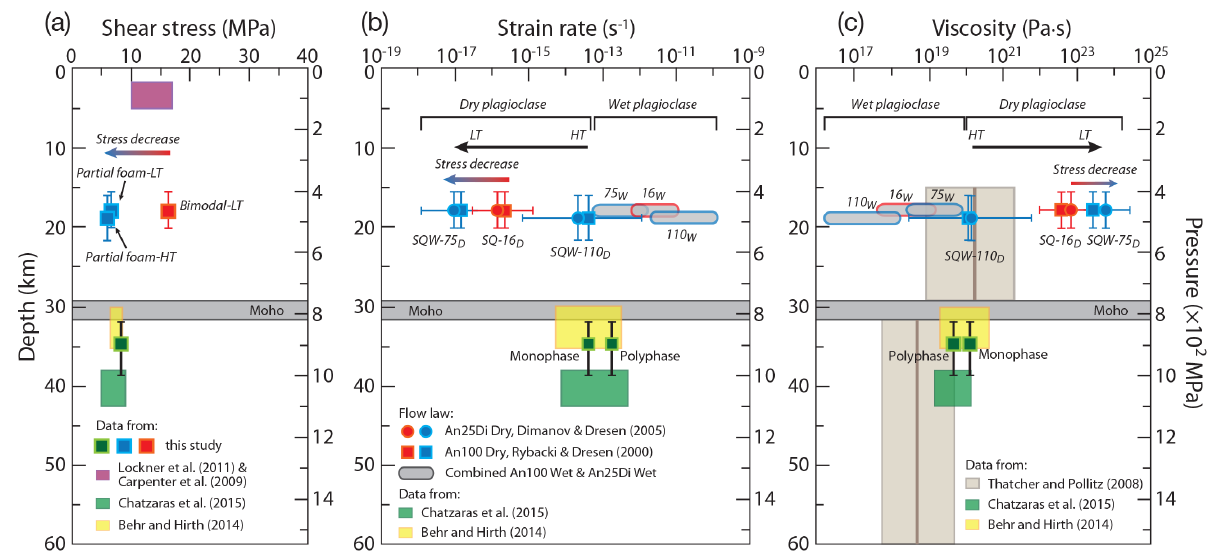
Figure 13. (a) Shear stress, (b) strain rate, and (c) viscosity as a function of depth for the San Quintín xenoliths. Error bars reflect the estimated uncertainties in pressure (vertical) and temperature (horizontal) conditions of deformation propagated to determine corresponding errors in stress, strain rate, and viscosity. Red symbols correspond to the xenolith with the bimodal grain size distribution, and blue symbols correspond to the xenoliths with the partial foam microstructure. The subscripts W and D next to the sample names describe whether a wet or a dry flow law was used. The Moho depth is from Paulssen and De Vos (2017). For explanation see